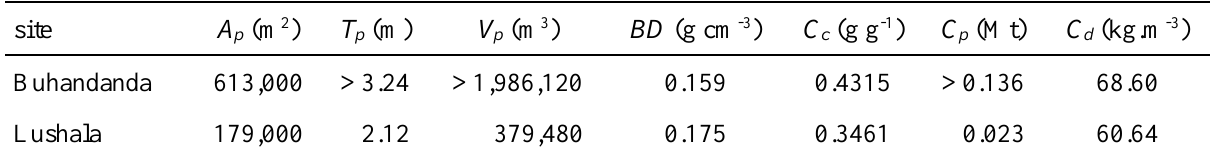
= surface area, T = peat depth, p p = C stock, C = C density. p d